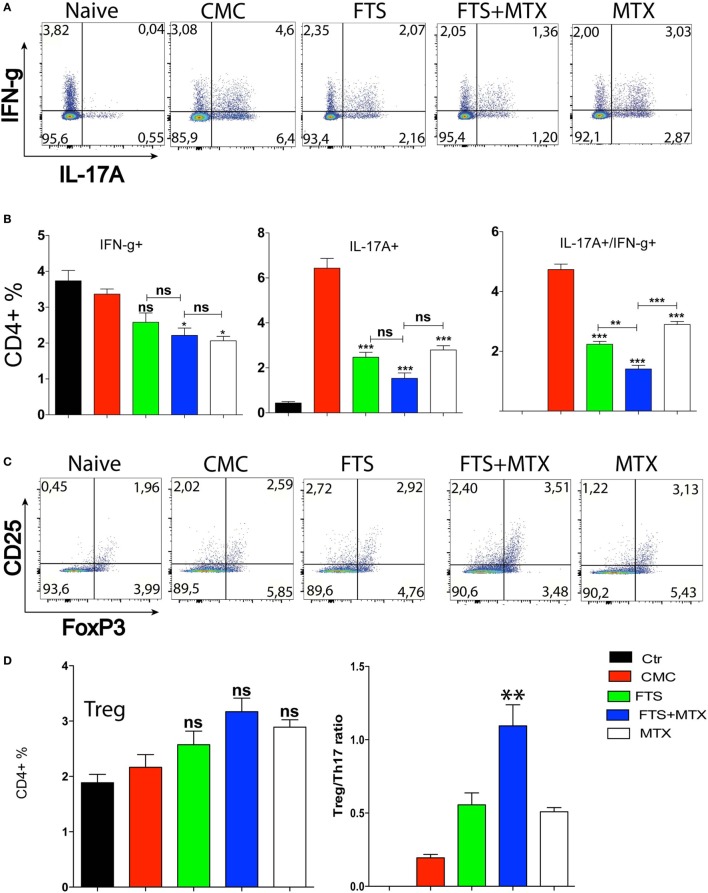
Immunomodulatory effect of farnesylthiosalicylic acid (FTS) treatment on the induction of Th1, Th17, and Treg subsets post CFA immunization. (A) Representative flow cytometry plots of intracellular staining for Th1 and Th17 cytokines producing CD4+ T cells. (B) Bars represent the percentage (mean ± SD) of the indicated Th-subsets in spleens of the various rat groups harvested at day 20 post CFA immunization (n = 5 per group). (C) Representative flow cytometry plots for Treg cells identification (CD3+CD4+FoxP3+ events). (D) Left hand Bars graph represent the percentage (mean ± SD) of Treg cells in the various rat groups (n = 5 per group). Right hand plot represents the Treg to Th17 ratio in these rats. Statistical significance was assessed by one way ANOVA with post hoc Bonferroni’s multiple comparison test (*P ≤ 0.05, **P ≤ 0.01, and ***P ≤ 0.001).